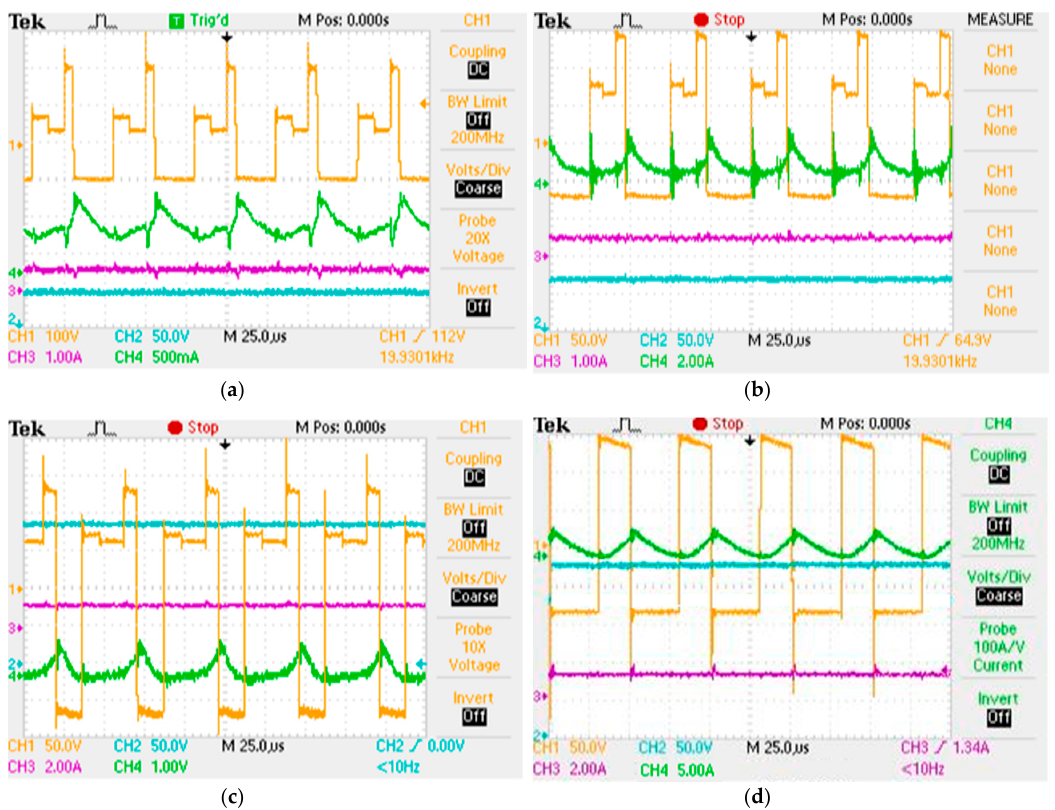
Figure 12. Experimental waveforms of the proposed converter: ( a ) Buck; ( b ) Buck-boost ( d < 0.5); ( c ) Buck-boost ( d > 0.5); ( d ) Boost [CH1: inductor voltage, CH2: output voltage, CH3: output current,